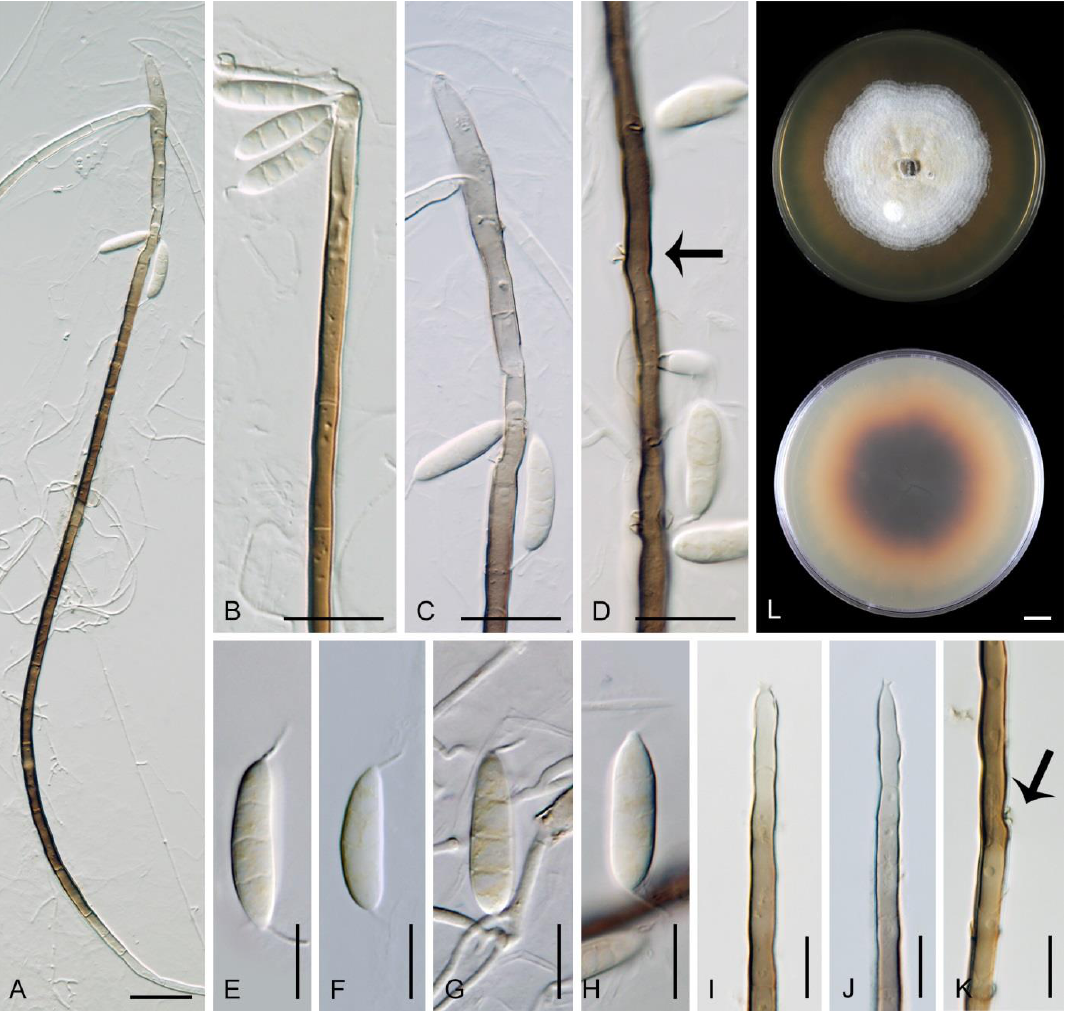
Figure 10. Multiguttulispora triseptata . (IMI 353690). ( A ) conidiophore ( B – D , K ) fertile parts of the conidiophores with lateral phialidic openings (arrows indicate collarettes) ( E – H ) conidia ( I , J ) tips of the conidiophores ( L ) colonies (front and reverse). Images: ( A – L ) on MLA after 8 weeks. Scale bars: ( A ) 25 μm; ( B – D ) 20 μm; ( E – K ) 10 μm; ( L ) 1 cm.